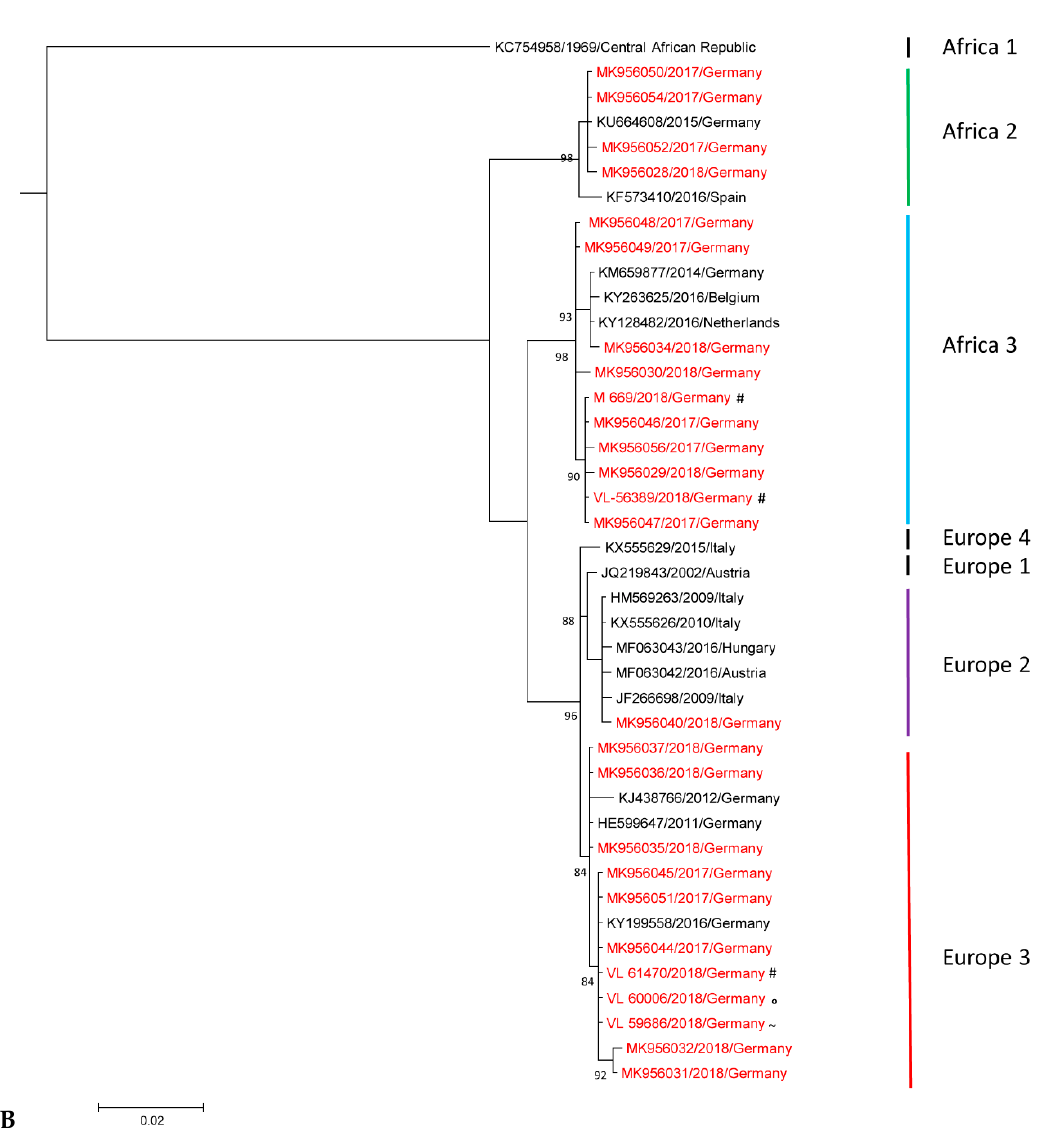
Figure 2. Phylogeny of the Usutu virus (USUV) isolates in 2017 and 2018. Sequences detected in 2017 and 2018 are highlighted in red. Taxon information includes the GenBank accession numbers, detection years, and countries of origin of the viruses. Scale bars indicate the mean number of nucleotide substitutions per site. Some samples had identical partial sequences, but are also depicted as they are from a different geographic region or year, respectively: (* = sequence identical to MK956004; # = sequence identical to MK956046; ° = sequence identical to MK956045; ~ = sequence identical to MK956044) ( A ) Phylogenetic tree of the detected USUV strains from Germany and Europe constructed from partial envelope genome nucleotide sequences (1066 nucleotides) sequenced by the FLI (Friedrich-Loeffler-Institute). ( B ) Phylogenetic tree of the detected USUV strains from Germany and Europe constructed from partial nucleotide sequences for the envelope protein (726 nucleotides) sequenced by the University of Leipzig.